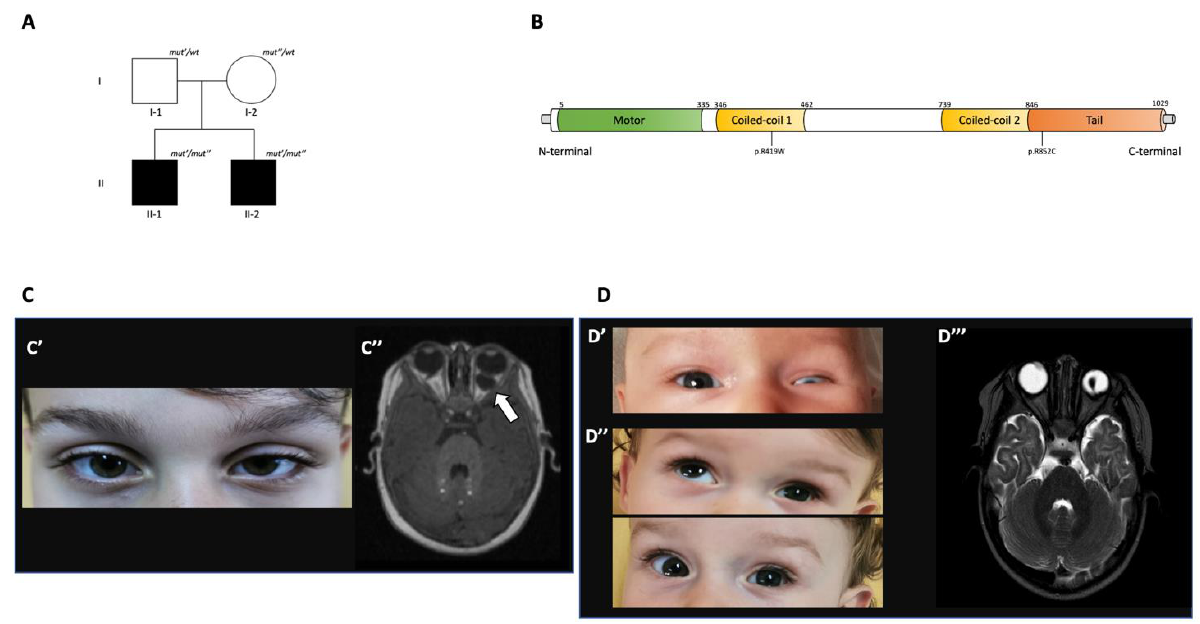
Figure 1. Family tree, KIF17 protein structure, and the clinico-radiological features of our siblings. ( A ) Pedigree from family. ( B ) KIF17 protein structure with domains and the two pathogenic variants found in our probands. ( C ) Clinico-radiological findings of Patient II-1. ( C (cid:48) ) Image of eyes showing left microphthalmia at age. ( C (cid:48)(cid:48) ) Brain MRI at age 7 months. Axial FLAIR images demonstrate bilateral focal posterior defects of the globes with vitreous herniation suggestive for bilateral posterior coloboma. In the left eye a fluid-density cist is also present (white arrow). ( D ) Clinico-radiological features of Patient II-2. ( D (cid:48) ) Image of eyes showing left microphthalmia at age. ( D (cid:48)(cid:48) ) Additional eye images taken at age. ( D (cid:48)(cid:48)(cid:48) ) Brain MRI at age 5 months. Axial T2-weighted image showing right “egg shaped” globe suggestive for posterior coloboma. In the left eye the “egg shape” is less deducible due to microphthalmia, as well as lens luxation.